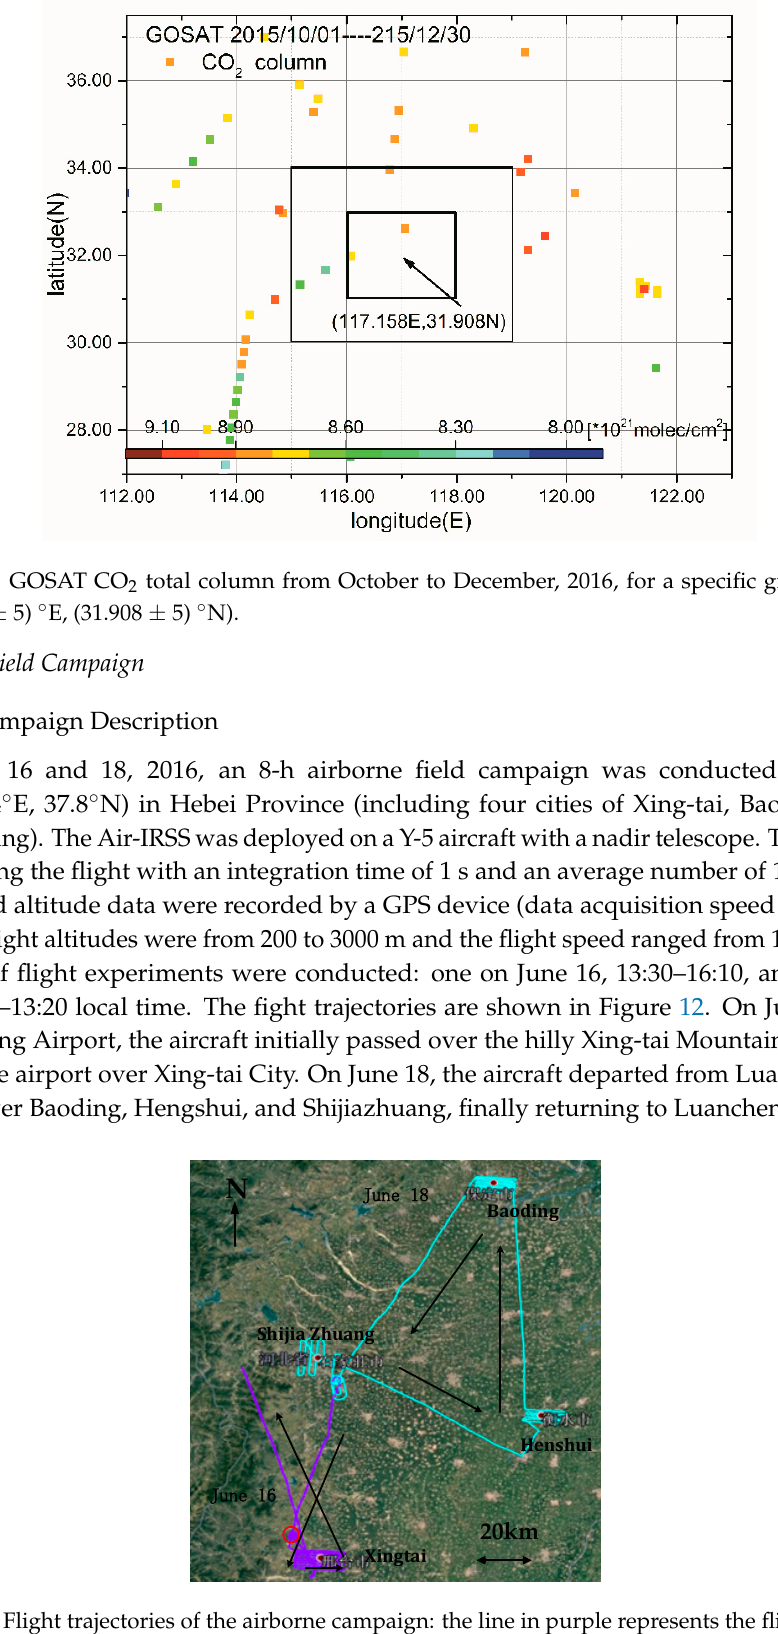
Figure 12. Flight trajectories of the airborne campaign: the line in purple represents the flight path on June 16, and the red circle indicates that the aircraft in the area is spiraling up and down; the line in blue represents the flight path on June 18, and the arrows represent the flight directions.